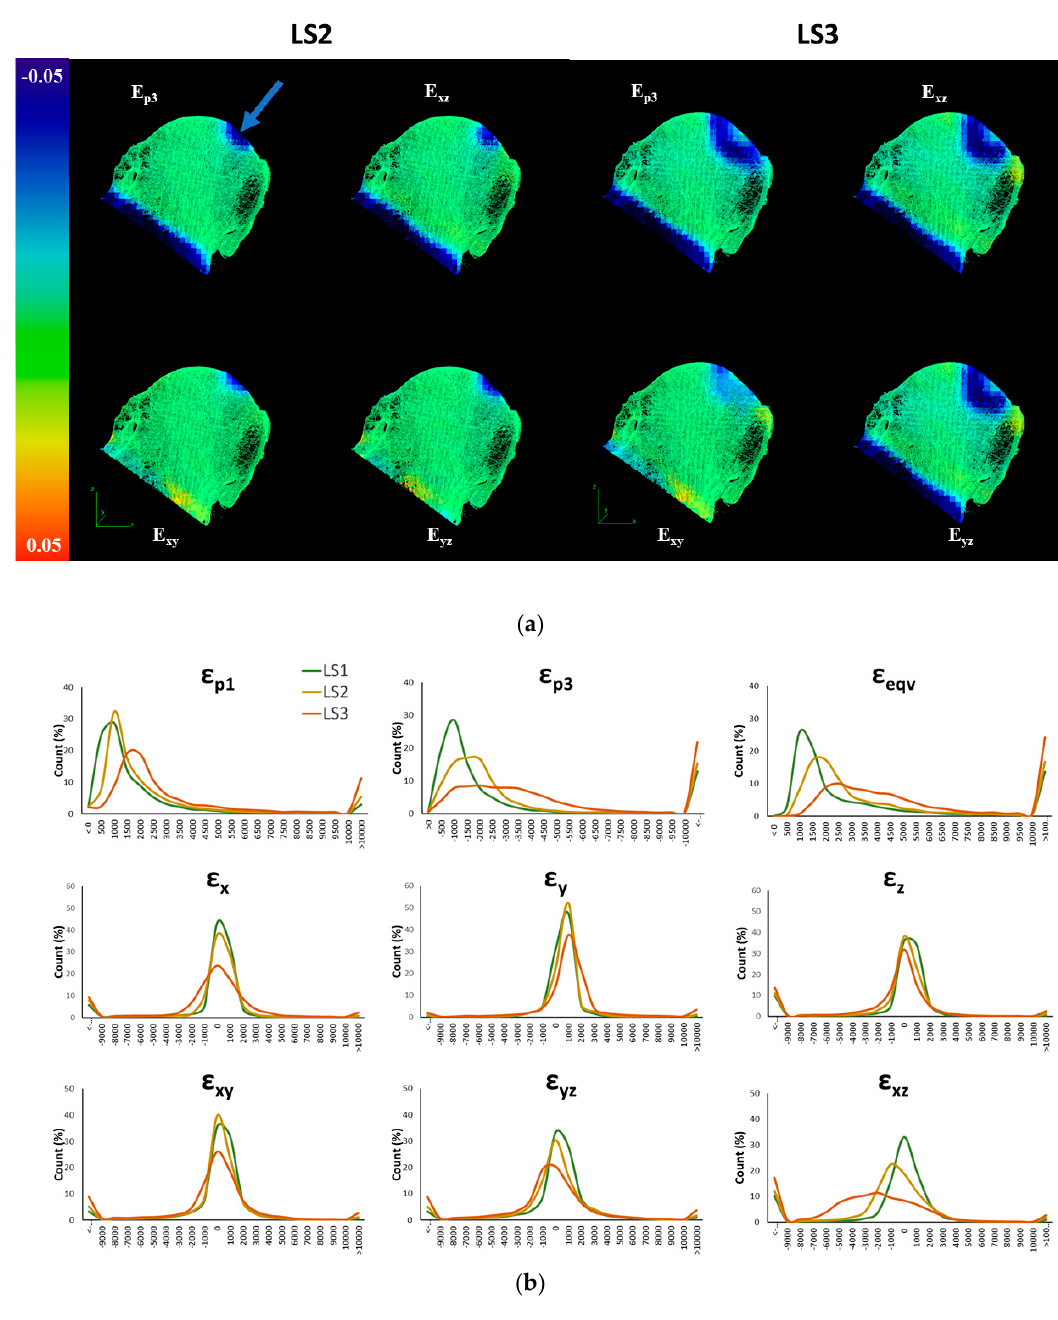
Figure A3. ( a ) 3D renderings showing 5 mm thick slices through the central region of bone with DVC output overlaid at LS2 (LEFT) and LS3 (RIGHT). The direction of applied load is indicated by the blue arrow. Strain components are noted at the top of each pictograph (TOP). ( b ) Histograms of strain distributions for each strain component ( ε p1, ε p3 ε eqv ε x ε y ε z ε xy ε yz ε xz) at the three load steps (LS1 (green), LS2 (yellow) and LS3 (orange)) (BOTTOM).